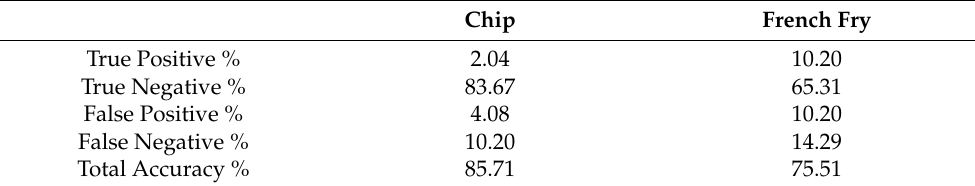
Table 2. Accuracy of tuber shape classification prediction model.